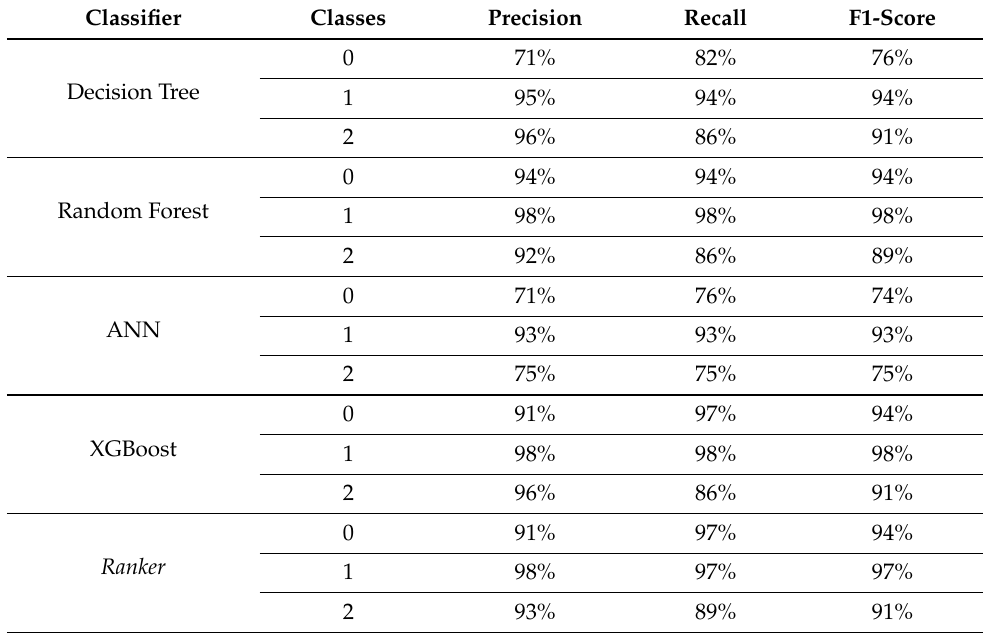
Table 3. Evaluation metrics for DT, RF, ANN, XGBoost, and Ranker